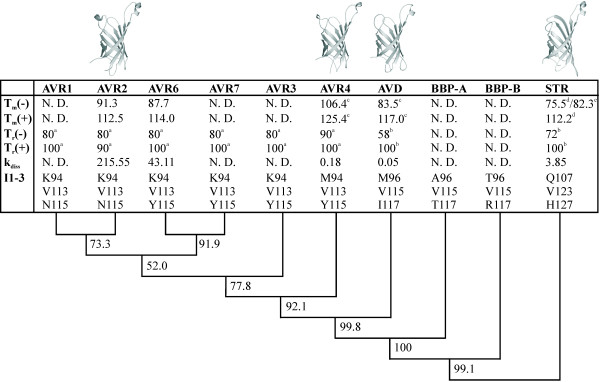
Summary of the biochemical properties and phylogeny of avidin (AVD) and the AVRs. The putative chicken biotin-binding proteins BBP-A and BBP-B [12] as well as streptavidin (STR) are included. The confidence levels of the branching of the phylogenetic tree were assessed using the bootstrap method [64]. The tree is unrooted and the branch lengths are not to scale. The values at each node represent the percentage of the 1000 trees where the species above the node are consistently found. Tm(-), heat-induced unfolding temperature without D-biotin (°C). Tm(+), heat-induced unfolding temperature in the presence of D-biotin (°C). Tr(-), transition temperature of oligomeric disassembly without D-biotin determined using SDS-PAGE assay (°C) [70]. Tr(+), transition temperature of oligomeric disassembly in the presence of D-biotin (°C). kdiss, biotin dissociation rate constant (× 10-6 s-1) obtained from global fitting [41] of the 3H-biotin dissociation data. I1–3, three residues important for the 1–3 subunit interface (equivalent to residues 94, 113 and 115 in AVR2). The residues in BBP-A and BBP-B are numbered according to avidin. N. D., not determined. aHytönen VP, unpublished data. Analysis performed on wt proteins produced in the baculovirus expression system as described in Ref. [35]. bFrom Ref. [70]. cFrom Ref. [36]. dFrom Ref. [71]. eFrom Ref. [72].